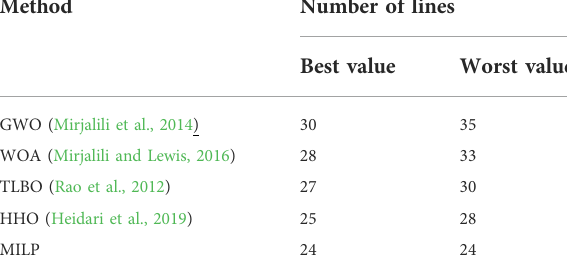
TABLE 4 Comparison with the heuristic methods for IEEE 39-bus system.